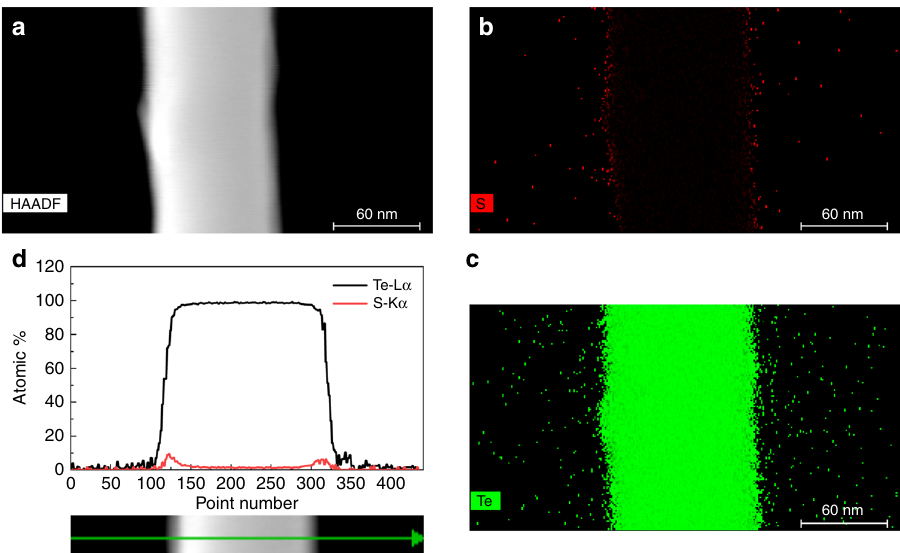
Fig. 2 Structural characterization of dopant location. a High-angle annular dark- fi eld scanning transmission electron microscopy (HAADF-STEM) and b , c energy-dispersive X-ray (EDX) maps of sulfur and tellurium, respectively, in a sulfur-doped tellurium nanowire showing the presence of minute amounts of sulfur in the sample d line scans demonstrating that sulfur atoms are primarily concentrated on the surface of the